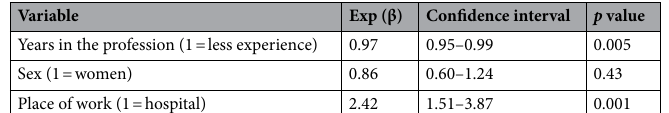
Table 4. Multivariable logistic regression model for care of COVID-19 patients.